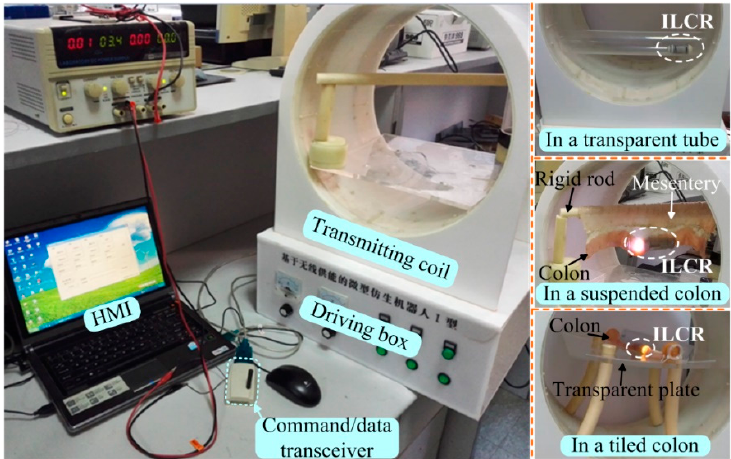
Figure 7. Experimental setup for testing the performance of the enhanced ILCR, and the test environments include a transparent tube, a suspended colon that is connected to a soft mesentery, and a tiled colon that is placed on a transparent plate.